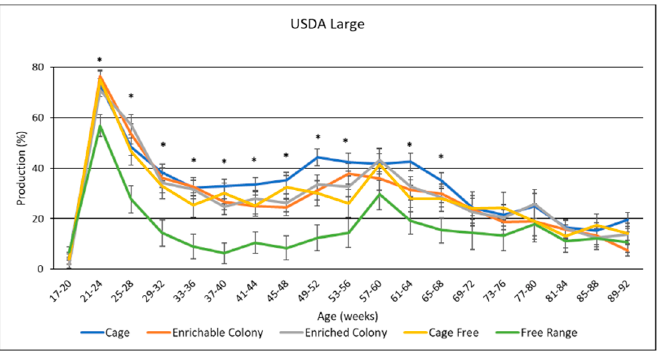
Figure 10. The effect of housing system on USDA large production of brown egg layers by age. * Signifies a significant effect ( p < 0.05) of housing environment during that age range on USDA large percentage.